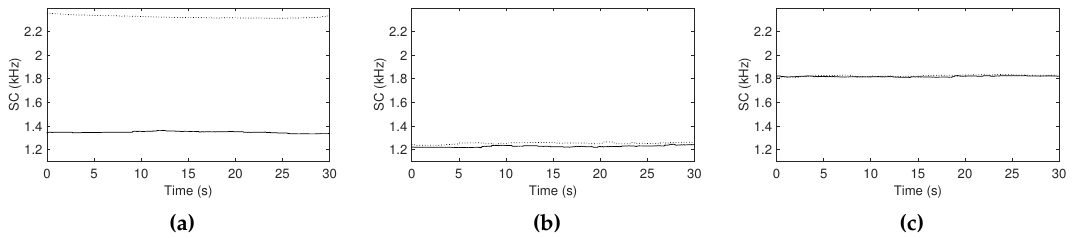
Figure 18. Spectral centroids measured when the diffusion parameter is set to ( a ) low, ( b ) middle and ( c ) high. Solid curves represent unmodified signals, and dot curves represent output signals mixed with the output of the one-pole high-pass filter, where the mix ratio between the two signals is controlled depending on the estimated